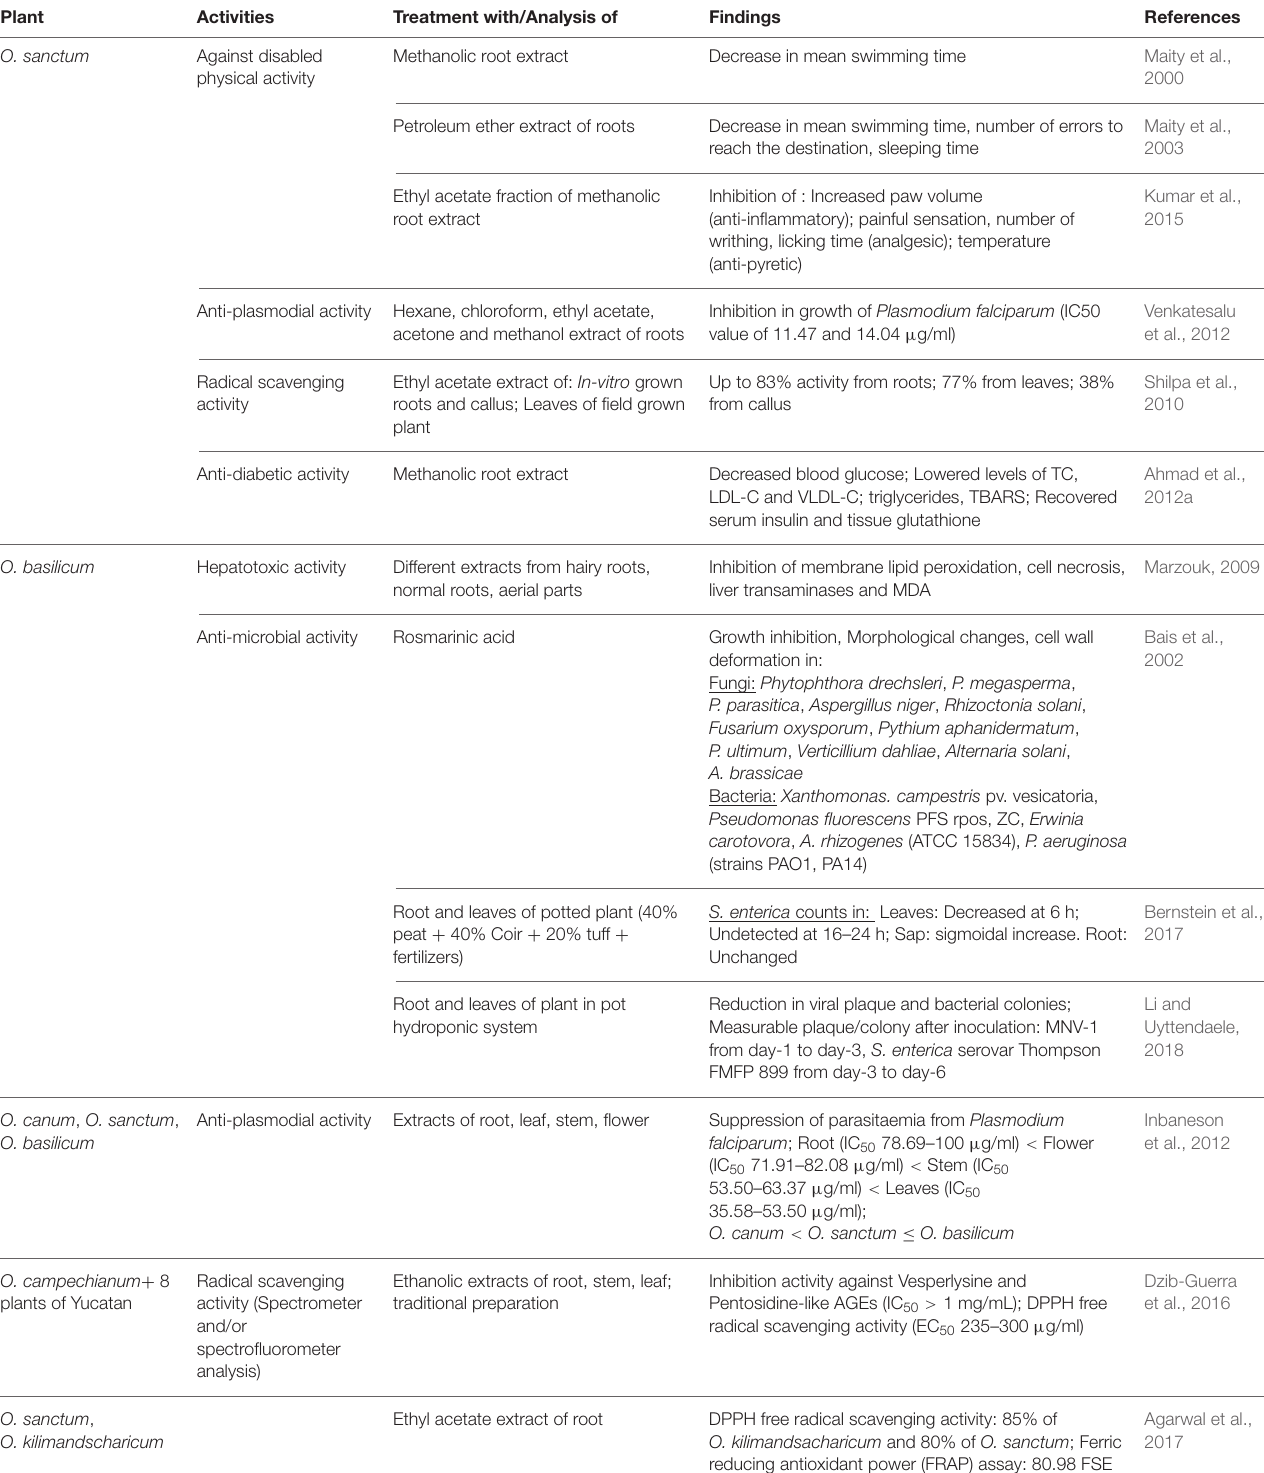
TABLE 1 | Medicinal properties of different extracts and purified components of Ocimum